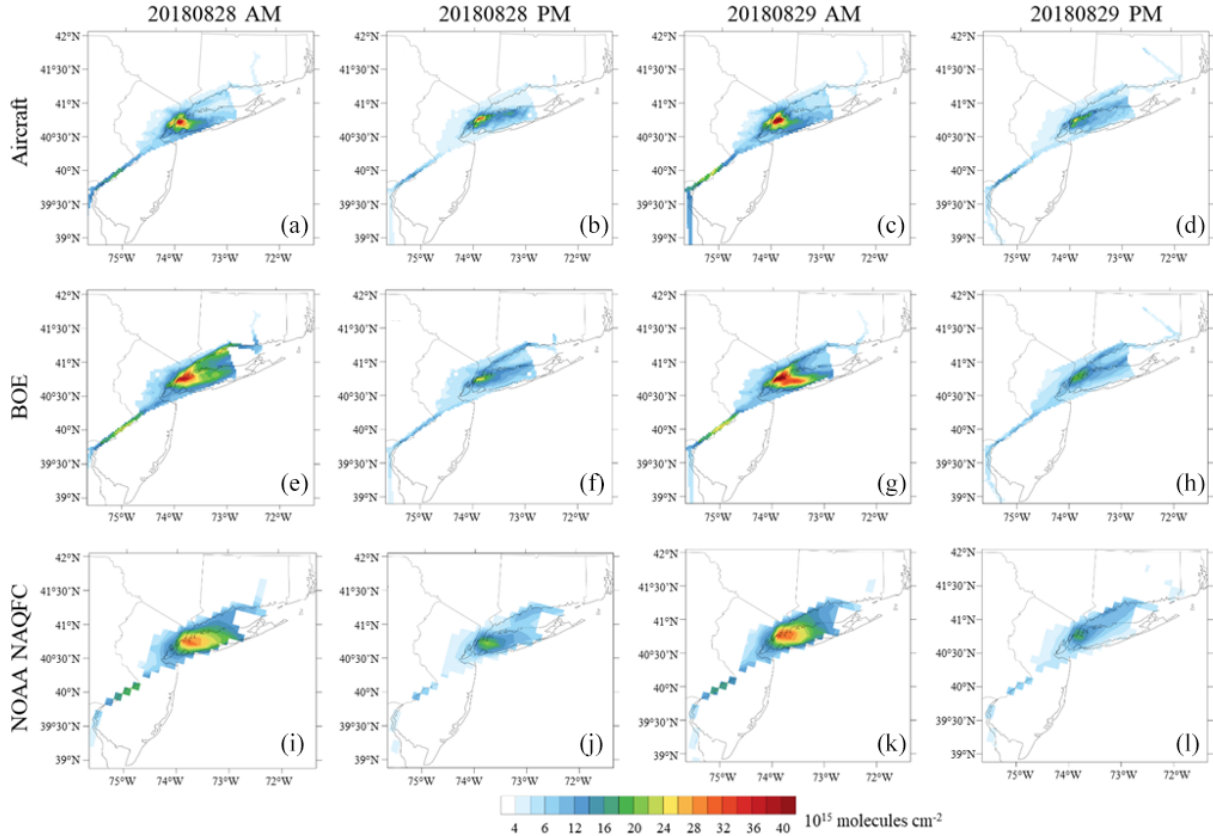
Figure 11. Spatial distribution of NO 2 vertical column density (VCD) observed by NASA GeoCAPE Airborne Simulator (GCAS) (top row) and simulated by the 3km BOE (center row) and 12km NOAA NAQFC (bottom row) over the LIS domain during 28–29 August 2018. There were two flight missions each day: the morning flight (AM) from ∼ 11:00 to 15:00UTC and the afternoon flight (PM) from ∼ 16:00 to